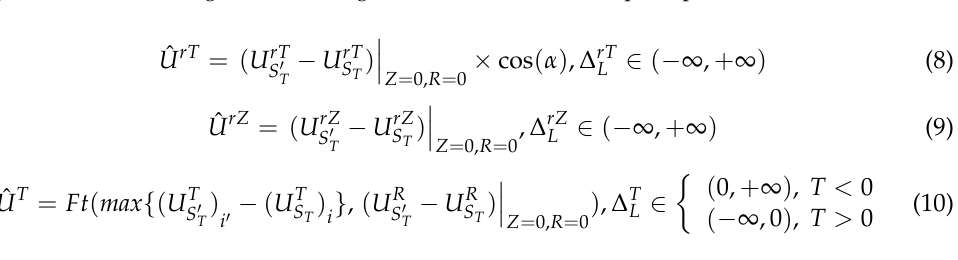
Figure 8. Schematic diagram of the longitudinal-seam lamination